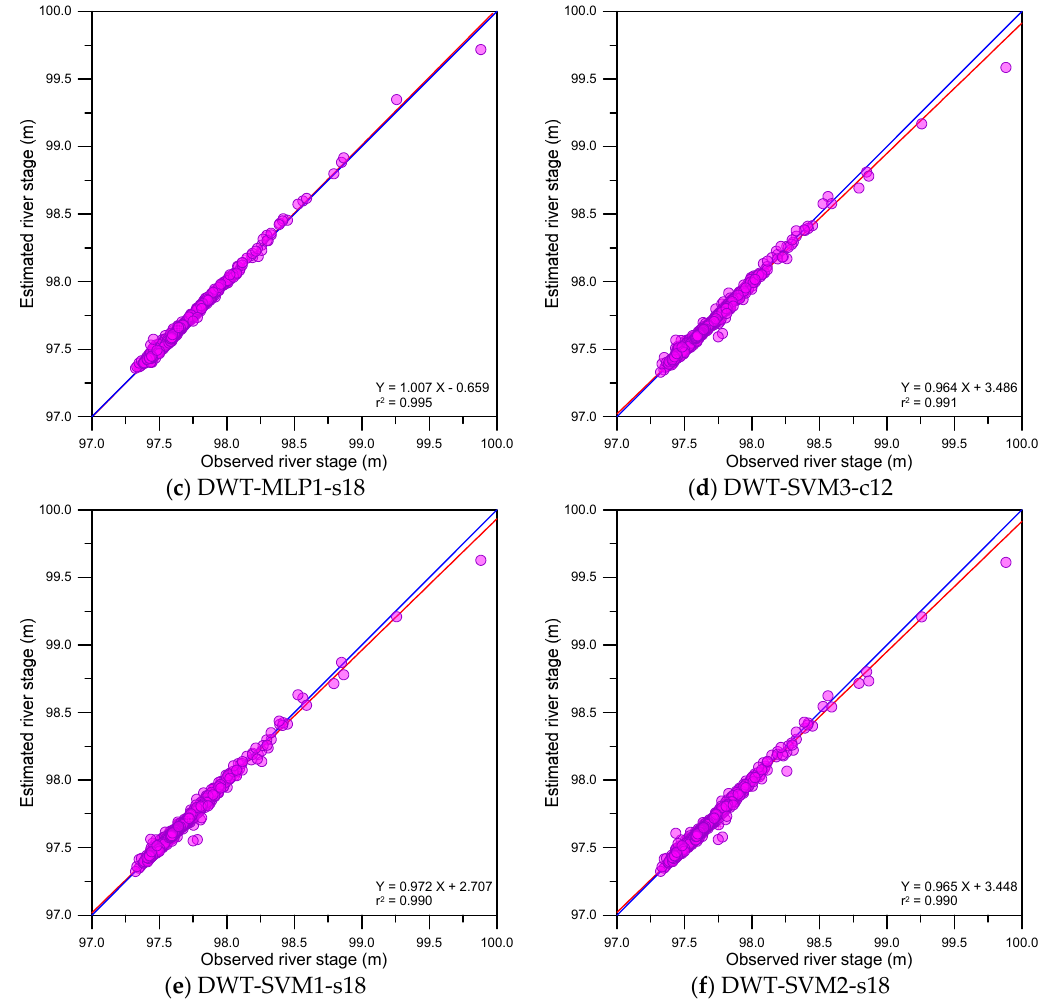
Figure 10. Scatter plots for DWT-based models.